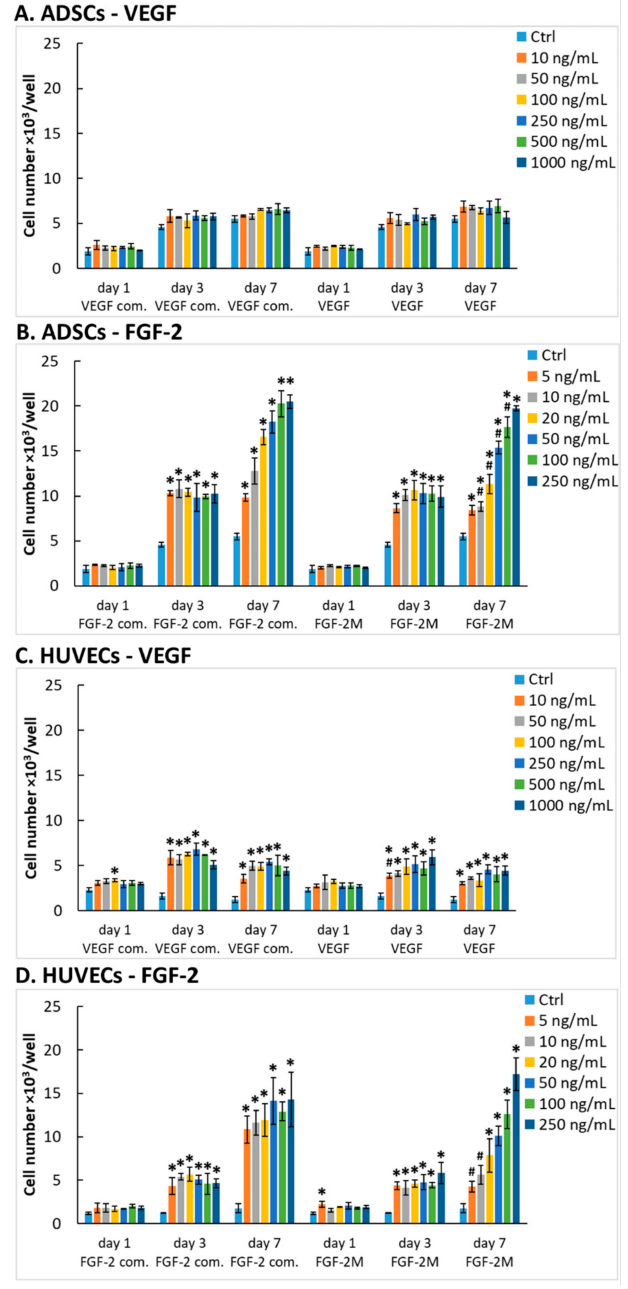
Figure 1. The mitogenic activity of vascular endothelial growth factor VEGF-A 165 and fibroblast growth factor FGF-2M diluted in the culture medium. The adipose tissue-derived stem cells (ADSCs) ( A , B ) or human umbilical vein endothelial cells (HUVECs) ( C , D ) were grown in media enriched with commercial VEGF-A 165 (VEGF com.) or our recombinant VEGF-A 165 in concentrations from 10 to 1000 ng/mL ( A , C ); in media enriched with commercial FGF-2 (FGF-2 com.) or our recombinant FGF-2M in concentrations from 5 to 250 ng/mL ( B , D ). The growth factors were added into Dulbecco’s modified Eagle medium (DMEM) with 10% fetal bovine serum (FBS) for ADSCs ( A , B ), and into EGM2-weak for HUVECs ( C , D ). Control cells were grown in media without growth factors (Ctrl). The cell number was determined on days 1, 3, and 7 after seeding. Mean ± standard deviation (SD) from 3 wells. Holm–Sidak method, p ≤ 0.05. The samples were statistically compared on the indicated day after seeding. Statistically significant differences are depicted above the columns. * statistically significant difference versus control sample (Ctrl). # statistically significant difference versus sample containing a corresponding concentration of commercial growth